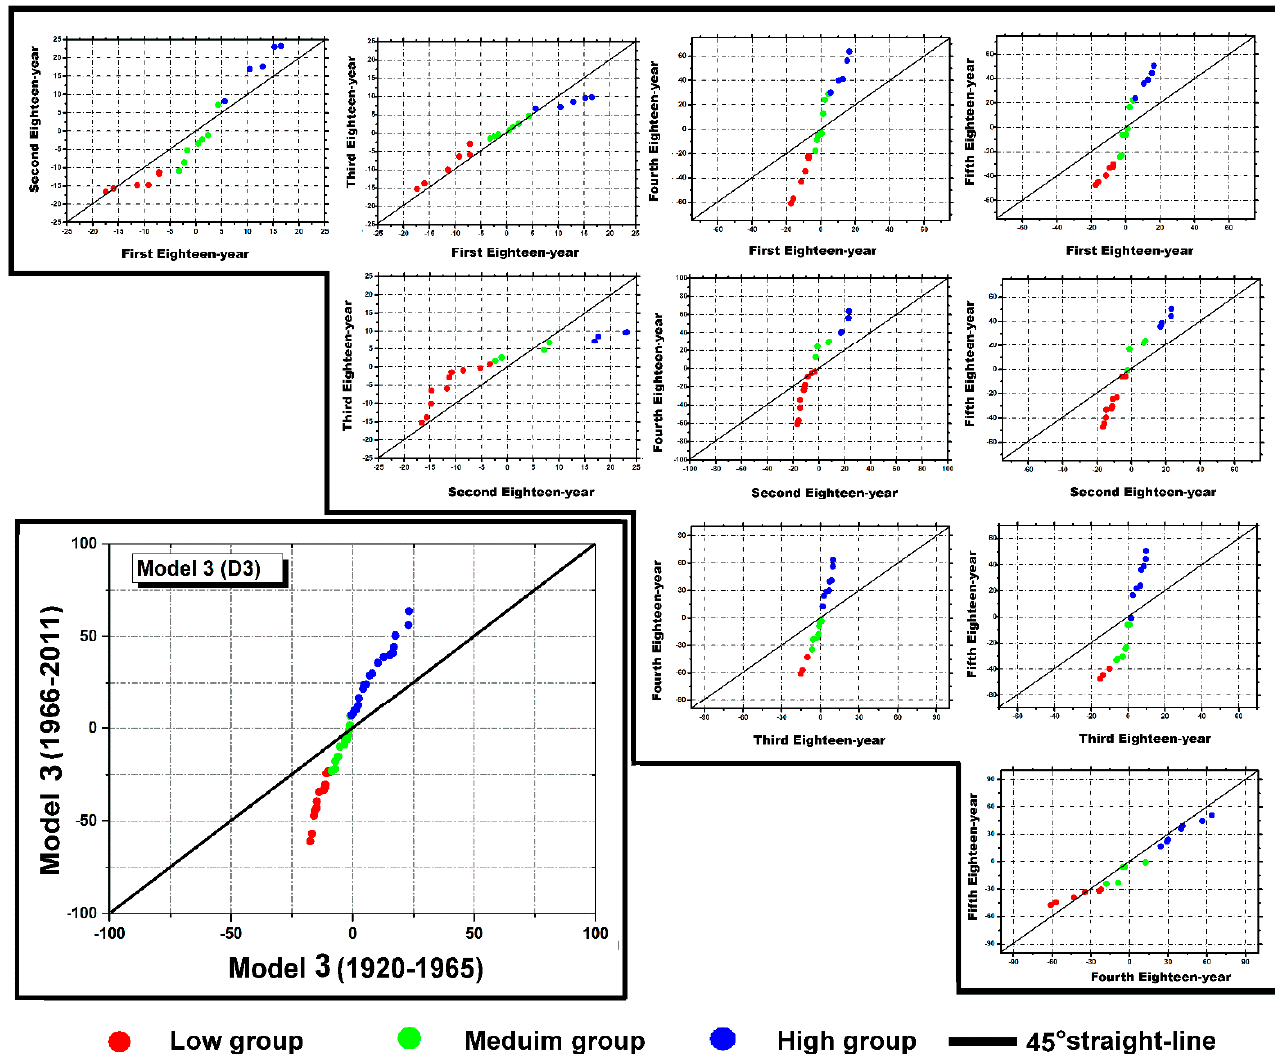
Figure 9. Triangular trend analysis methodology applied on rainfall Model (M3) resulting from DWT (ITTM − DWT: hybrid method) of Ain Beida station.